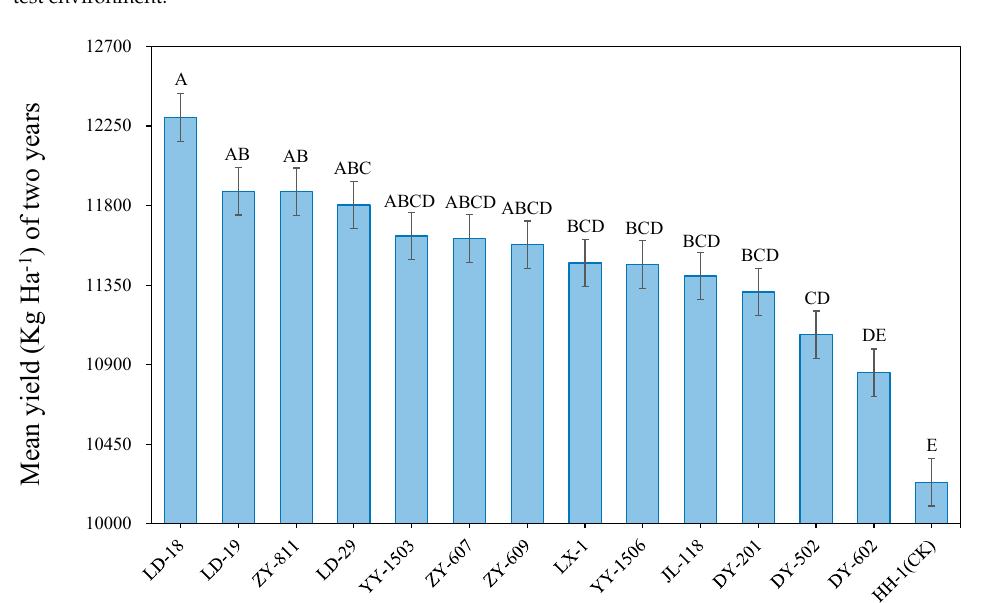
Figure 1. Mean yield (kg ha − 1 ) of 14 maize hybrids over two years. Different letters indicate significant differences ( p < 0.01).